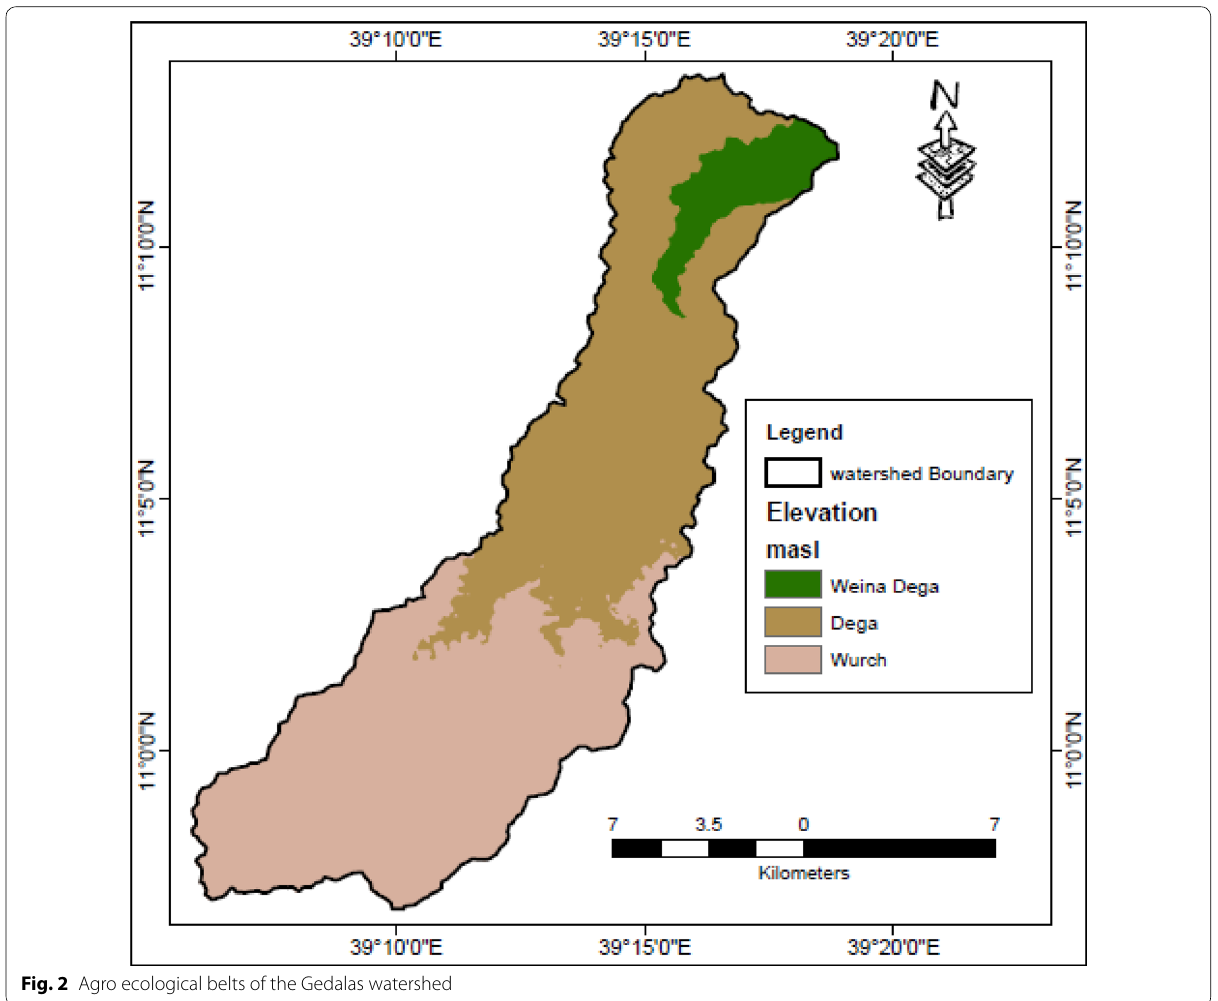
Fig. 2 Agro ecological belts of the Gedalas watershed